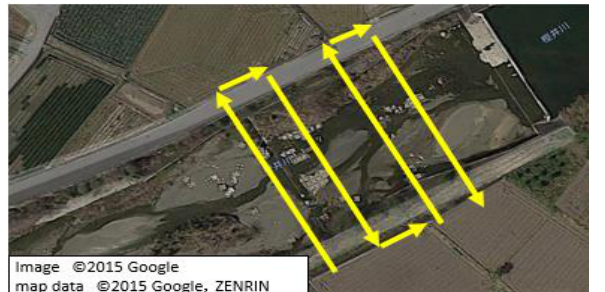
Figure 4. Flight route